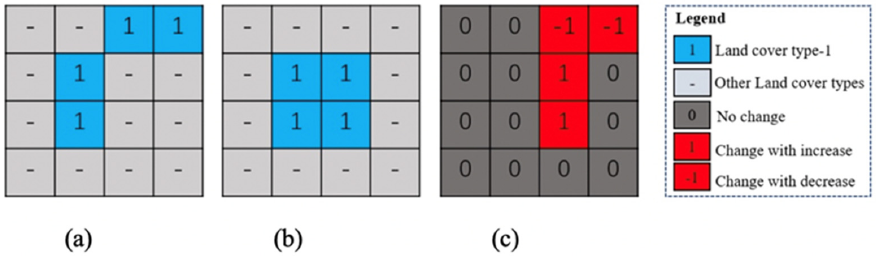
Figure 2. Single type of LCC. ( a ) Land cover map at T1; ( b ) Land cover map of T2; ( c ) Land cover change results between T2 and T1.